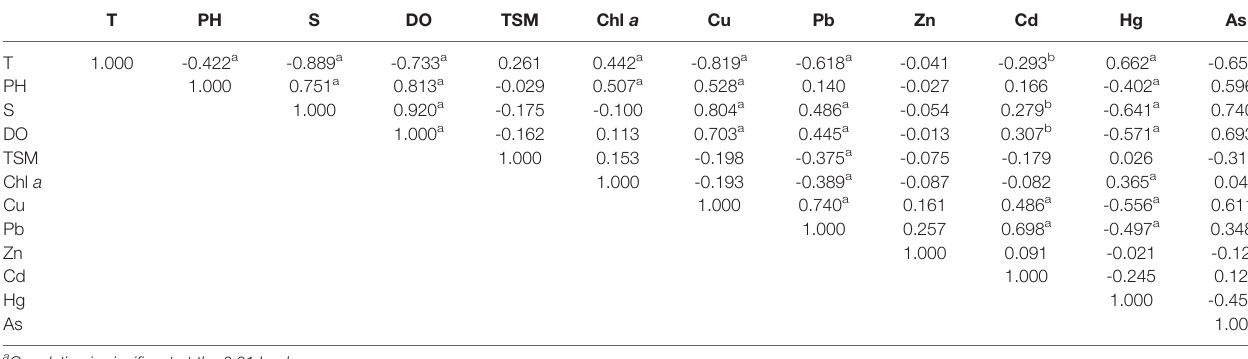
TABLE 5 | Correlation analysis between heavy metal concentrations and the physicochemical parameters in surface water.